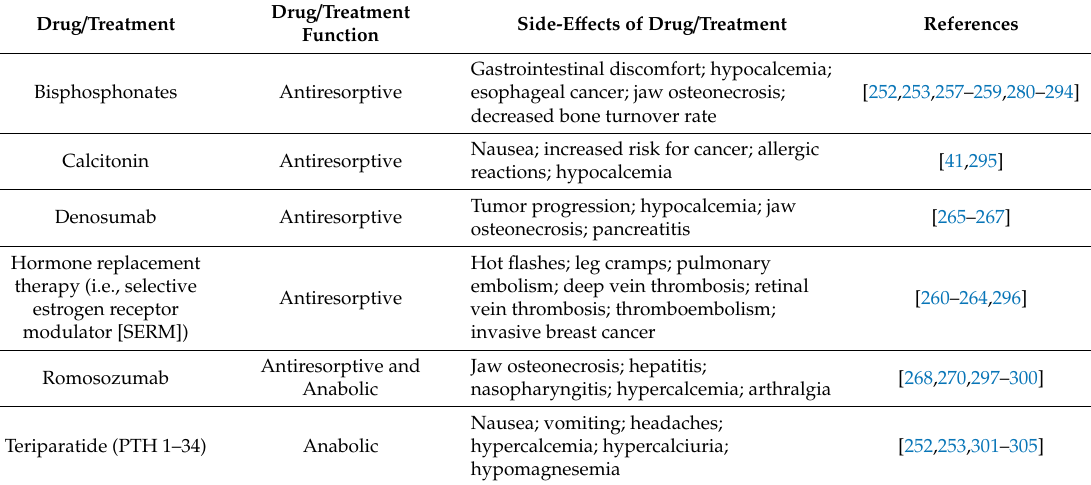
Table 3. Current osteoporosis treatments, function of the drugs / treatments, and the drug / treatment side-e ff